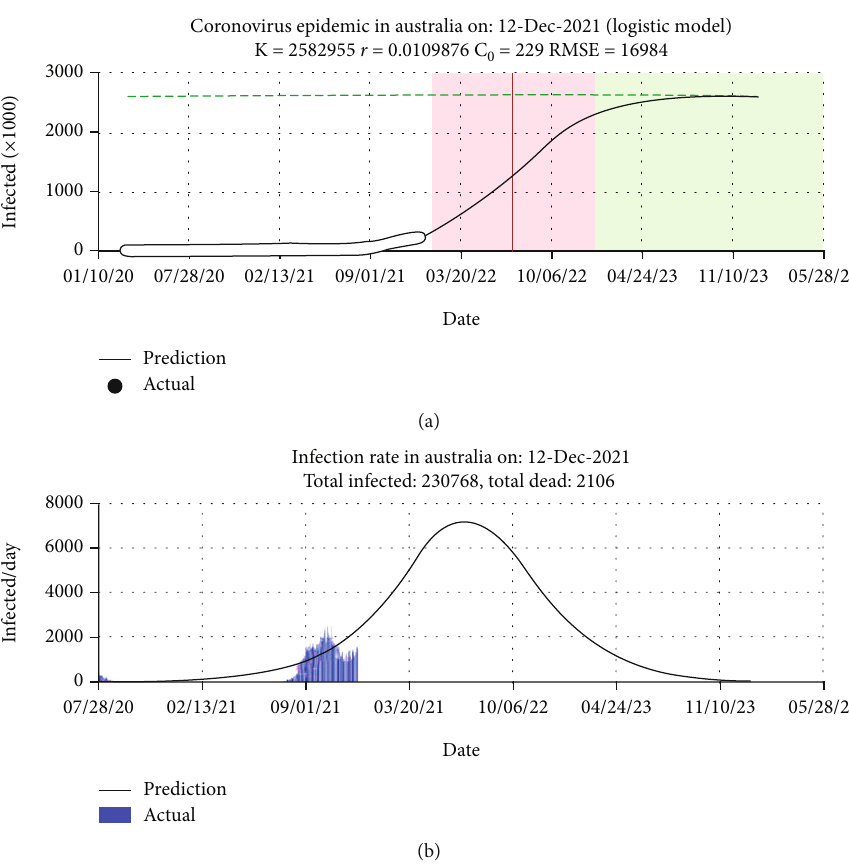
Figure 2: Performance of proposed system in Australia: (a) prediction plot and (b) histogram